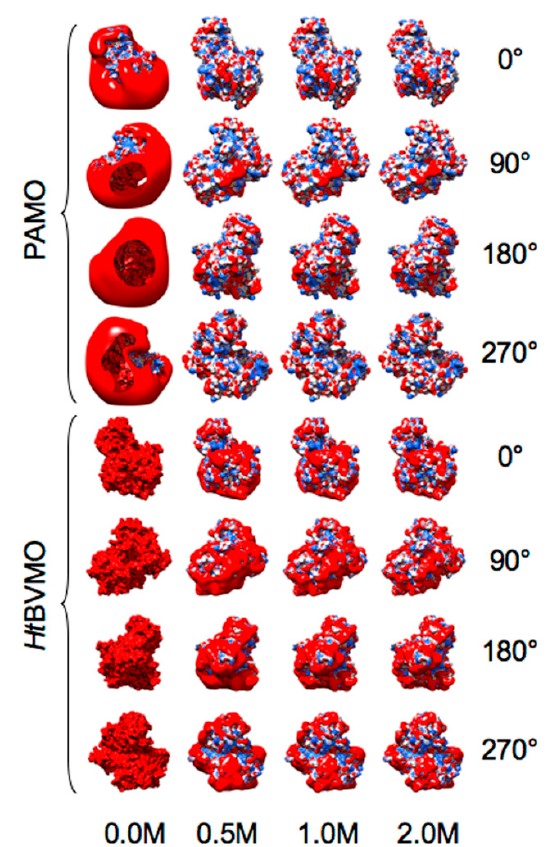
Figure 1. Comparison of the surface electrostatic isopotential contours of PAMO and Ht BVMO at increasing NaCl concentrations. The electrostatic analysis was performed as reported in the Materials and Methods section, based on coordinates from the PAMO-solved structure (PDB 1W4X) and the Ht BVMO structural model (PAMO is the template). Four views, 90° step angle of rotation are provided. Electrostatic potential is color-coded: red, negative; white, neutral; blue, positive.